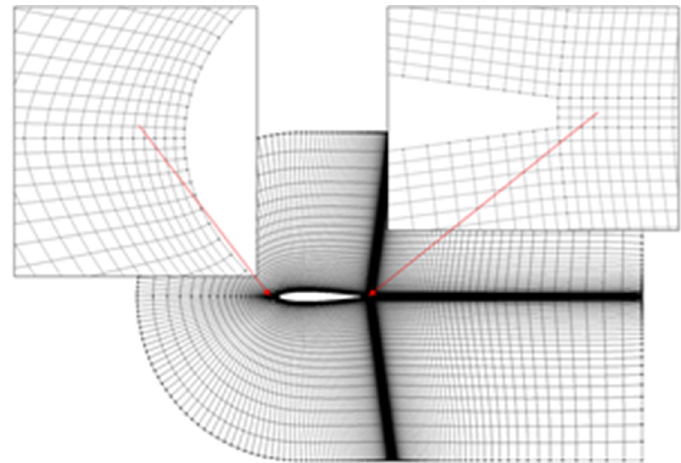
Figure 5. The C type mesh.